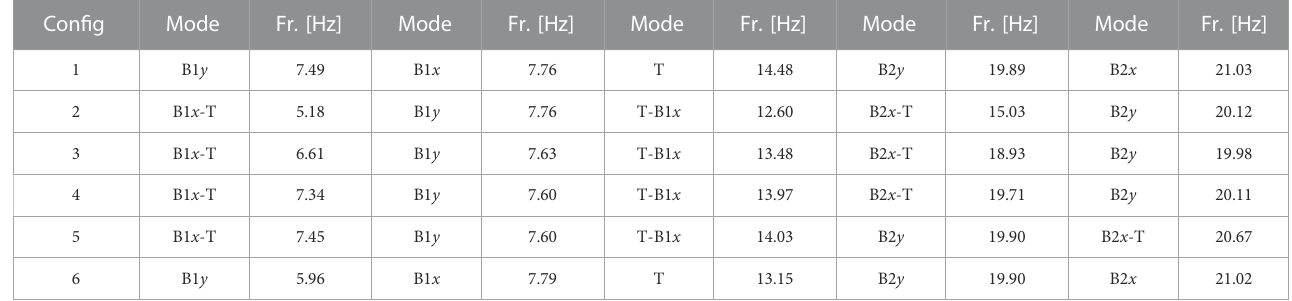
TABLE 6 ASCE benchmark structure: natural frequencies in Hz of the identi fi ed modes for the different con fi gurations. B1: fi rst bending mode; B2: second bending mode; T: torsional mode; x or y : mode direction. Con fi g